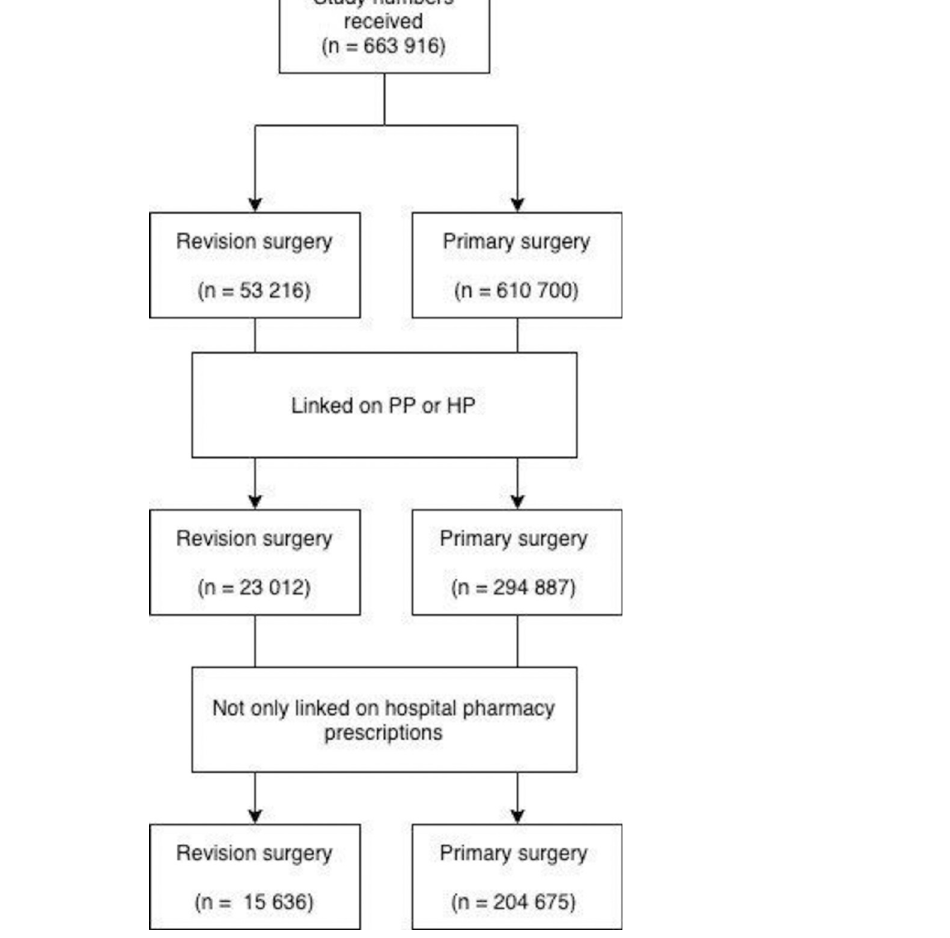
Fig 1. Flowchart describing the data linkage of primary and revision arthroplasties with data from the SFK. PP: person postcode; HP: hospital postcode.